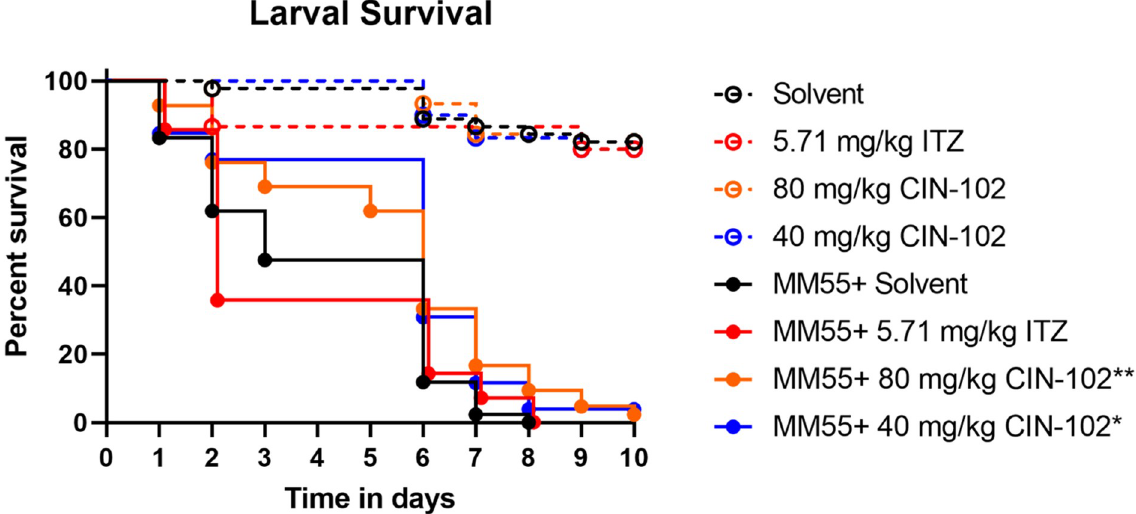
Fig 2. In vivo efficacy and toxicity of different dosages CIN-102 and the used treatment dosage itraconazole within G . mellonella larvae, compared to the solvent (PBS 10% tween80). Dotted lines indicate uninfected larvae as toxicity controls, which were treated at the same time points as the infected groups. It is observed that none of the shown dosages effect the survival of uninfected larvae. The full lines indicate infected larvae treated with the corresponding dosages 4-, 28- and 52-hours post-infection. Larvae treated with solvent and itraconazole survive up until day 8, while larvae treated with 40 mg/kg and 80 mg/kg survive up until day 10 and significantly differ from the PBS control ( � p = 0.0133 �� p = 0.0091).